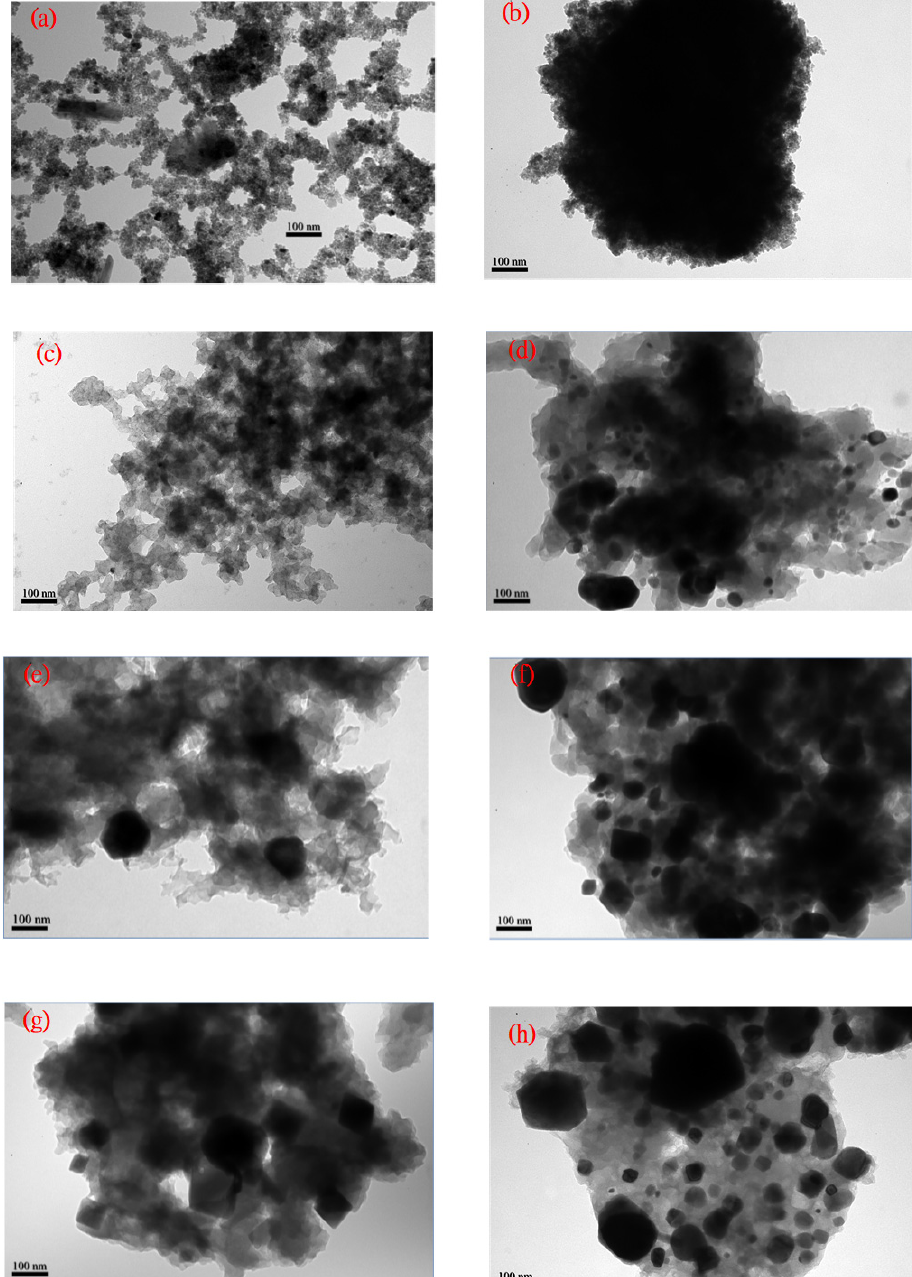
Figure 5. TEM micropictures of ( a ) Fe 3 O 4 (OA), ( b ) PANI(EB)/Fe 3 O 4 (OA), ( c ) FeNC-600, ( d ) FeNC- 650, ( e ) FeNC-700, ( f ) FeNC-800, ( g ) FeNC-900, ( h ) FeNC-950. 650, ( e ) FeNC-700, ( f ) FeNC-800, ( g ) FeNC-900, ( h ) The juxtaposed fibrous PANI(EB), fully covered with Fe 3 O 4 (OA) nanoparticles (PANI(EB)-Em/Fe 3 O 4 (OA)), can also be seen in Figure 6a. These fibers, which merged into